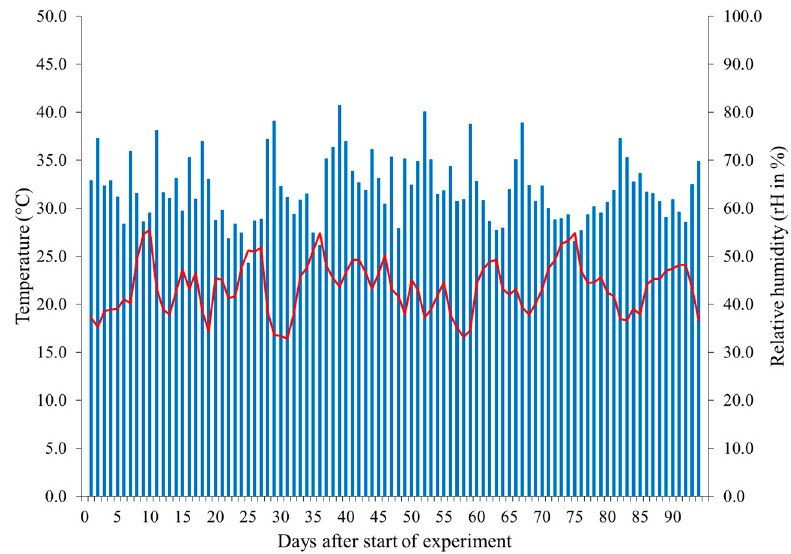
Figure A1. Daily mean values of air temperature and air humidity in the open greenhouse during the experimental period from fruit set until harvest in 2016.